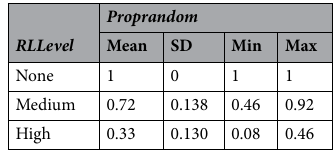
Table 2. The Distribution of proprandom by RLLevel , n = 15 in each